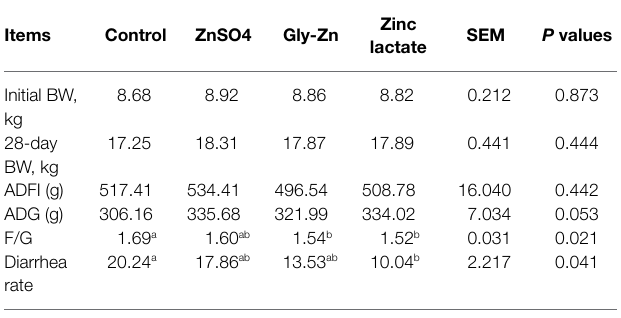
TABLE 4 | Effect of dietary zinc sources on the growth performance and diarrhea rate in weaned piglets. Items